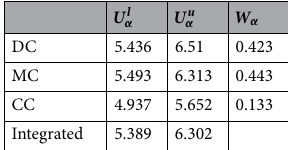
Table 6. Step data based on Eqs. (33)–(35).